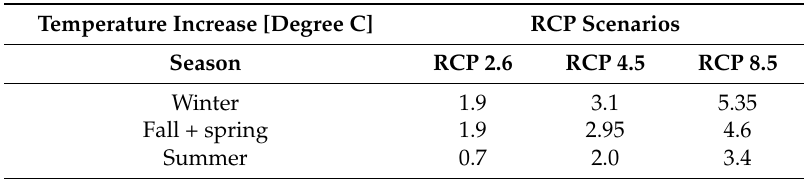
Table 1. Expected temperature increase used in the three scenarios, distributed across the three seasons. The numbers are based on calculations in Hanssen-Bauer et al. [2].